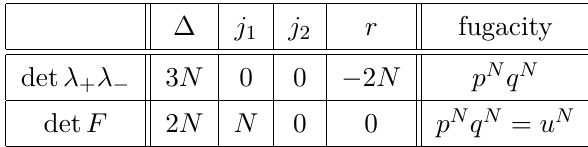
Table 2 . Charges of determinant operators in the N = 1